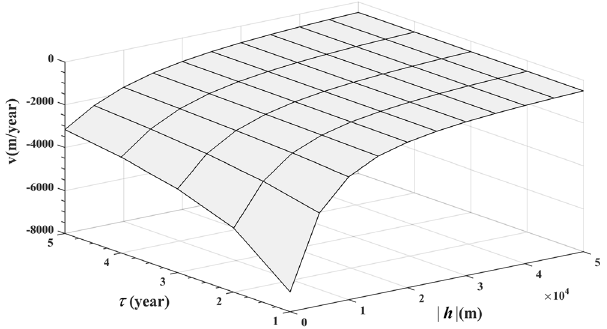
Figure 3. Plot of the BC incidence spread velocity (in m/year) as a function of space lag, | h | and time lag τ